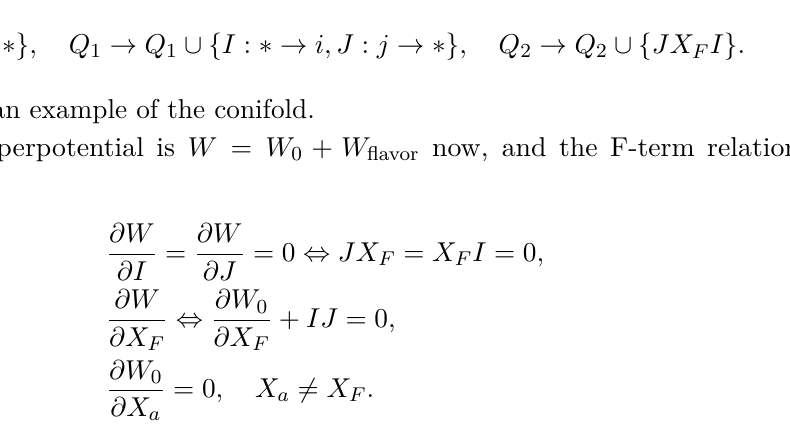
for the i = { β = { α = { α , and m = { β 1 1 } , m 2 2 } , m 3 1 } 4 2 }